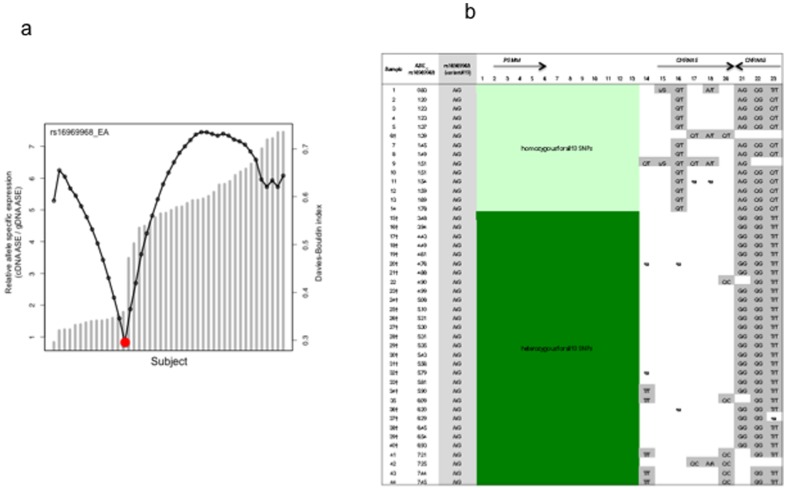
Allele specific expression (ASE) analysis with rs16969968 in 44 frontal cortices of European ancestry.2a. Davies-Bouldin (DB) validity index analysis. Columns represent the ASE. Dotted line represents the DB validity index. The red dot indicates the optimal cutoff predicted by the DB index that coincides with ASE. 2b. Concordance of allelic expression variation with heterozygosity. Samples #1 to #14 which show relative allelic expression balance (*ASE<2) are homozygous for the 13 highlighted SNPs. Samples #15 to #44 which show relative allelic expression imbalance are heterozygous for all 13 SNPs. *See material and method for details; ASE: allele specific expression. † Indicates samples are also heterozygous for rs615470.